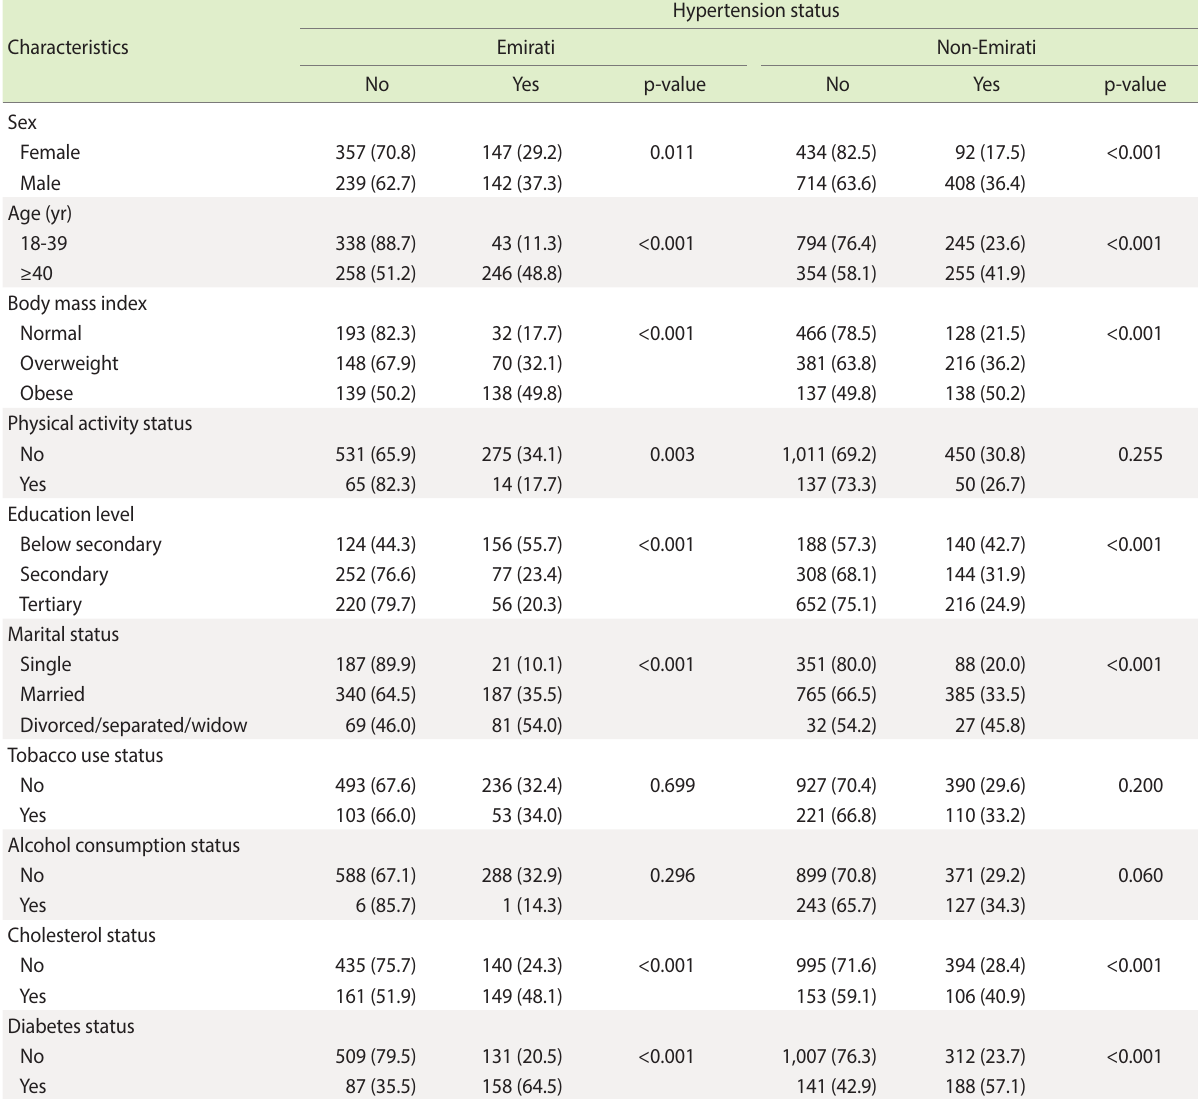
Table 1. Characteristics of study subjects based on nationality and hypertension status